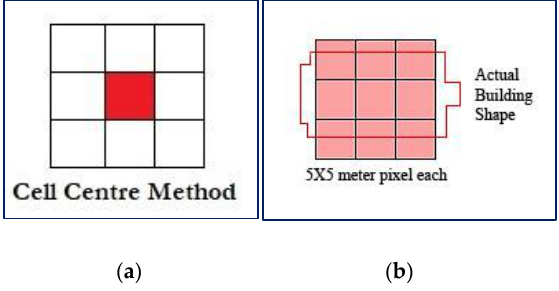
Figure 13. Error in the pixel conversion process. (13a) image shows the cell center conversion process and (13b) image shows the error that occurred during the conversion.